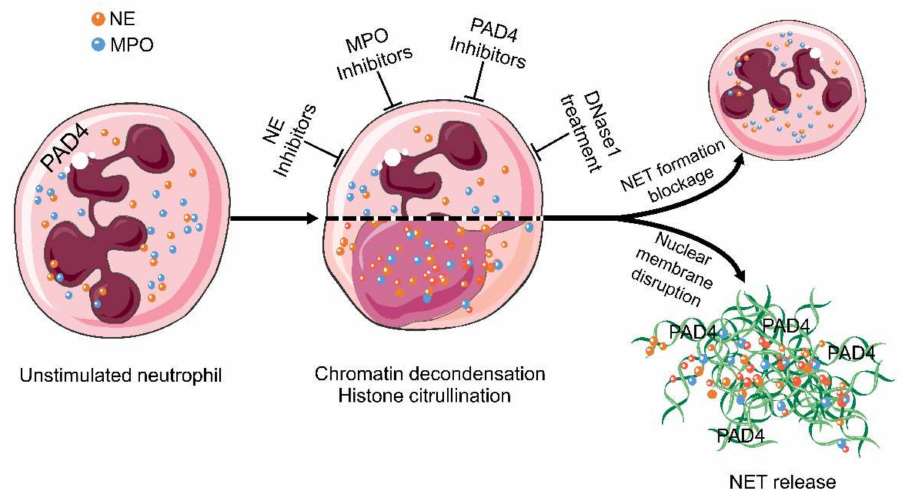
Figure 3. Targets in the treatment of aggNETs-driven occlusive pathologies. NE, MPO, PAD4, and extracellular DNA are promising targets for the suppression of excessive NETs formation. Enzymatic inhibitors of PAD4 and MPO have demonstrated its effectivity in preclinical settings of cholelithiasis, Meibomian gland dysfunction, and vasculitis. DNase treatment is effective at preventing death in severe sepsis and improving the symptoms in cystic fibrosis, bronchiolitis, and dry eye disease. The cartoons were modified from https://smart.servier.com accessed on 20 August 2021 in compliance with the terms of the Creative Commons Attribution 3.0 Unported License (CC BY 3.0). Abbreviations: MPO, myeloperoxidase; NE, neutrophil elastase; NET, neutrophil extracellular traps; and PAD4, peptidylarginine deiminase type